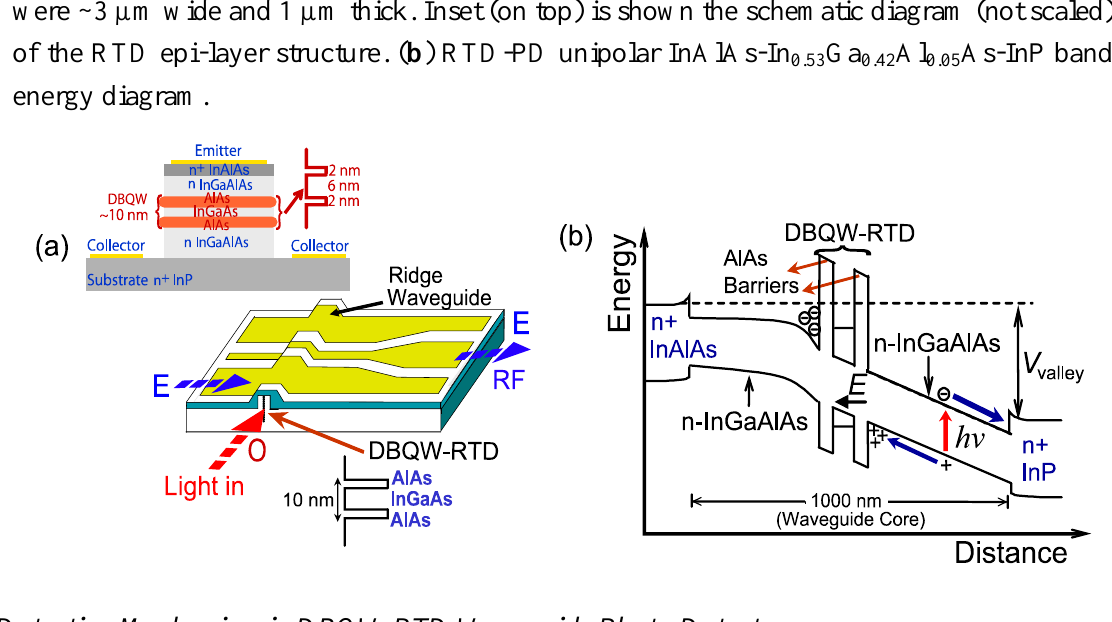
Ga Al As-InP band 0.53 0.42 0.05